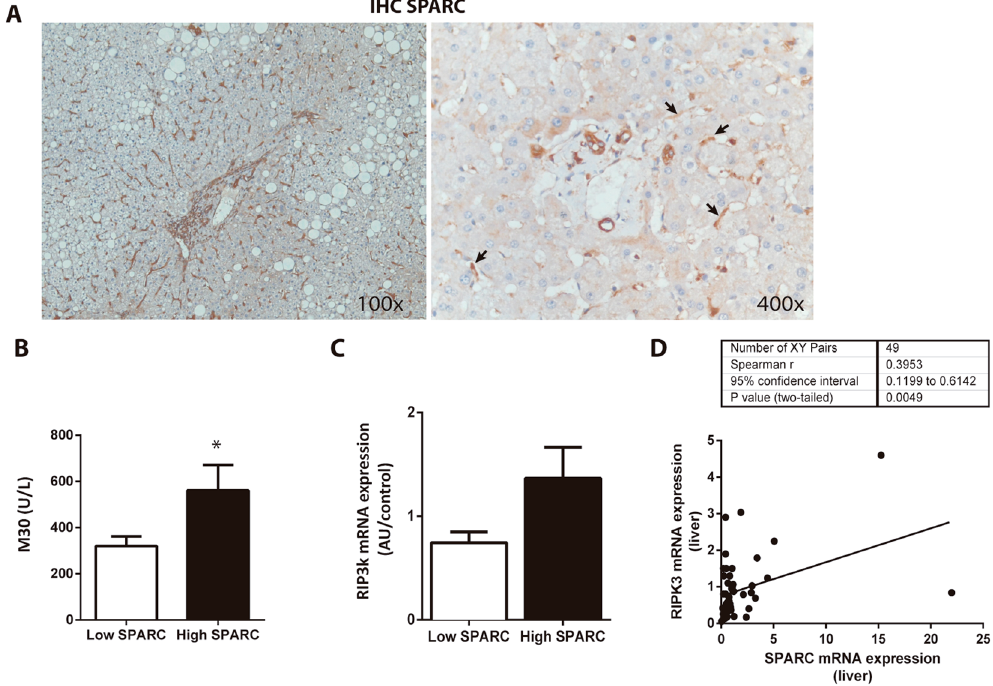
Figure 1. SPARC expression in patients with NAFLD induced liver injury. ( A ) Expression of SPARC was observed on protein (immunohistochemistry) in patients with NAFLD. Magnification 100 × and 400 × . Patients with high hepatic SPARC mRNA expression had significantly higher serum M30 levels ( B ) and nominally higher RIPK3 mRNA expression ( C ). Data are mean ± sem, * p < 0.05. Comparison between groups was performed with Mann-Whitney U Test. mRNA expressions of SPARC and RIPK3 were significantly correlated ( D ). Spearman rank